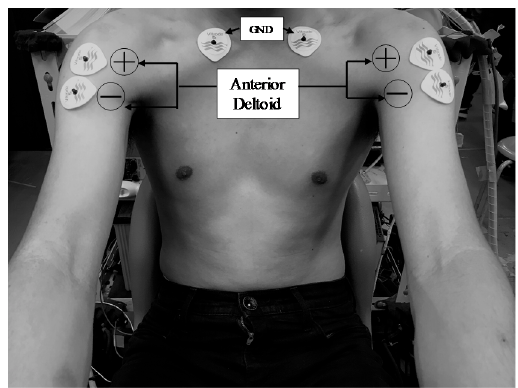
Figure 8. Photograph of positions of electrodes.